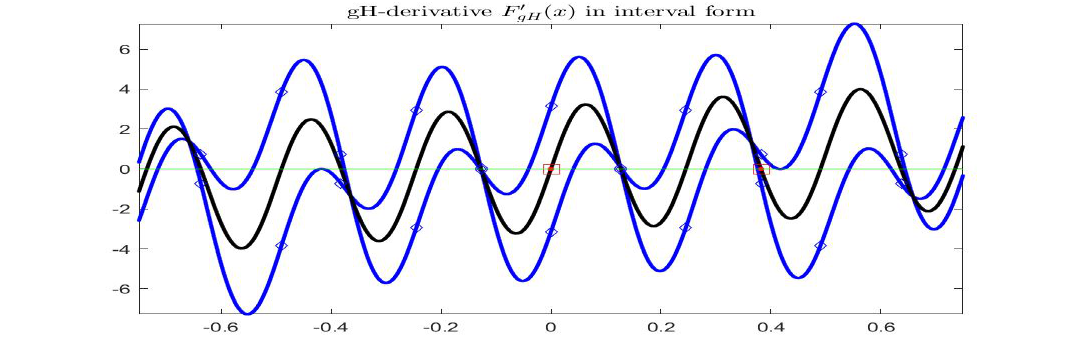
( x ) in interval form; black curve is (cid:98) f (cid:48) ( x ) . gH